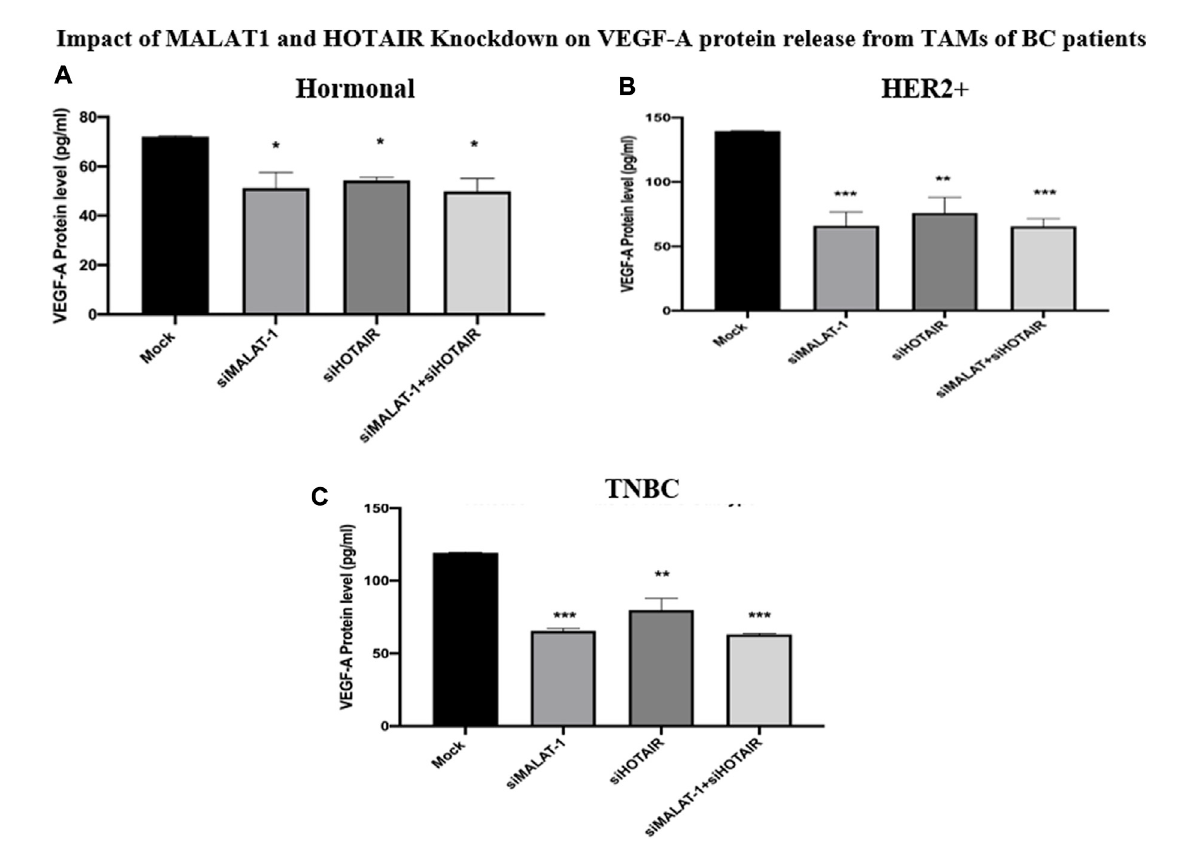
FIGURE 8 Impact of MALAT1 and HOTAIR knockdown on VEGF-A protein release from TAMs of (A) hormonal (B) HER2+, and (C) TNBC. The ELISA technique was used to measure the levels of VEGF-A in TAMs of the three subtypes. The results showed signi fi cant downregulation of VEGF-A protein release from TAMs of the hormonal, HER2+, and TNBC either upon silencing MALAT1 and HOTAIR separately or their co-silencing together incomparisonto untransfectedcontrols(mocks).One-way Anova followedbyDunette ’ stestof multiplecomparisonwas usedfor thepurpose ofcomparisonbetweenmorethantwodifferentstudiedgroups.****= p < 0.0001,***= p < 0.001,**= p < 0.01,*= p < 0.05,andns=statisticallynot signi fi